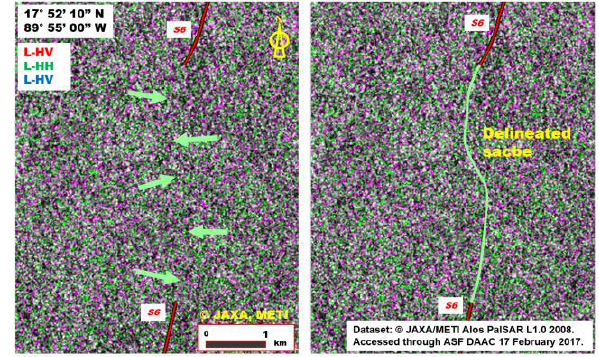
Figure 10. Connection between two segments of Sacbe #6 (S6) of Folan et al. (1995) located inside a densely forested area, as displayed on a false-colour composite made with the Alos-1 PalSAR radar image (L-HV band in the red and red, L-HH band in the green) acquired in May 2016: The location of the sacbe is indicated on the left panel by green